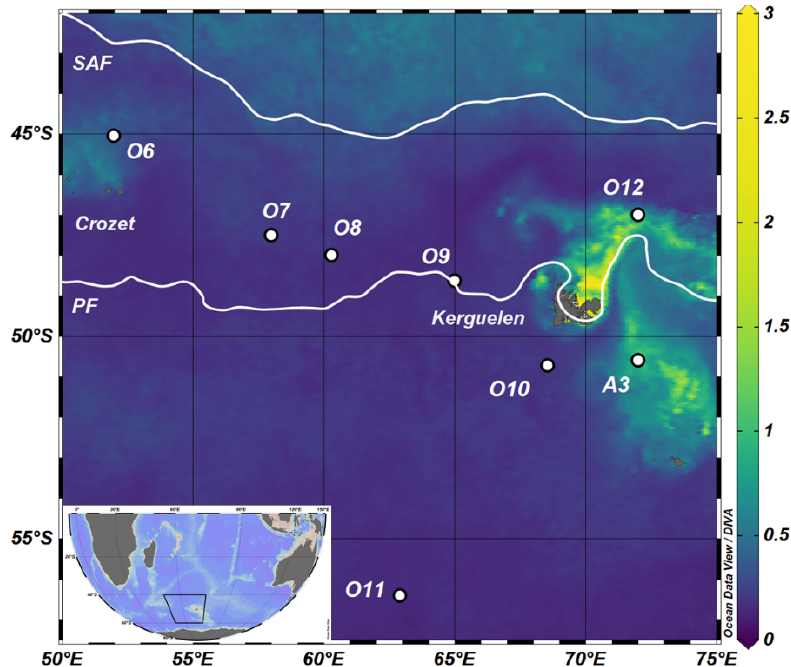
Figure 1. Map of the Indian sector of the Southern Ocean. The eight stations reoccupied are identified by white circles. The two major fronts are represented by white lines: the sub-Antarctic (SAF, 12 ◦ C isotherm) and the polar (PF, 5.2 ◦ C isotherm) fronts. The background corresponds to the summer climatological surface waters chlorophyll a concentration (mgm − 3 ) (Aqua Modis data generated by Nasa’s Ocean Color: https://oceancolor.gsfc.nasa.gov/ (last access: 15 June 2017); January 2002–2017 composite with a spatial resolution of 4km). Figure produced with ODV (Schlitzer,